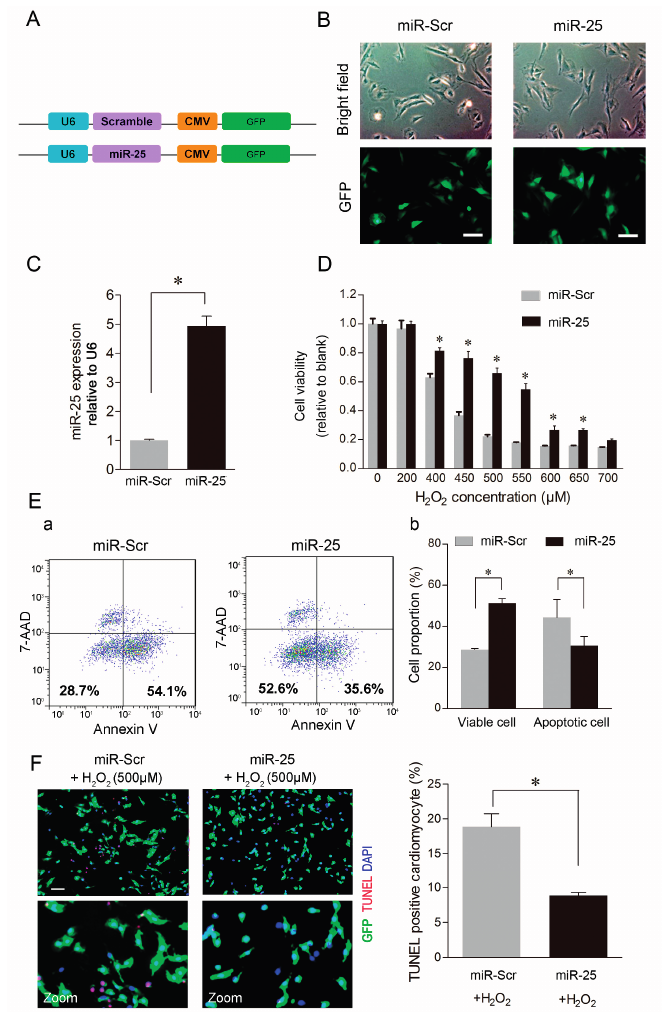
Figure 2. Over-expression of miR-25 markedly reduced cardiomyocyte apoptosis. ( A ) Schematic illustration of the construction of the lentivirus vectors. H9c2 cells infected with lentiviruses containing miR-25 precursor (miR-25) or a scramble control sequence (miR-Scr) were isolated by fluorescence-activated cell sorting (FACS) based on the green fluorescence emitted from cells expressing GFP, the marker carried by the lentivirus vector, and then plated in 24-well plates for expansion; ( B ) The phase contrast and fluorescent images of H9c2 cells infected with lentiviruses containing miR-25 or miR-Scr. Scale bars: 100 μ m; ( C ) Quantitative RT-PCR showed that miR-25 expression was 4.94 ± 0.34-fold higher in the miR-25 group than that in the miR-Scr group. * p < 0.05 vs. miR-Scr; ( D ) H9c2 cells were stimulated with H 2 O 2 and subjected to CCK-8 assay. Serial concentrations of H 2 O 2 were applied to examine the effects of miR-25 overexpression; ( E ) Panel a : representative dot-plot diagrams of FACS analysis on H9c2 cells stained with annexin V and 7-AAD. The lower left quadrants represents the viable cells (Annexin V − /7-AAD − ), and the lower right quadrants represents the apoptotic cells (Annexin V + /7-AAD − ); Panel b : percentages of viable and apoptotic cells; ( F ) Representative images and quantification of the TUNEL assay. Apoptotic cells were stained red by the TUNEL assay. Scale bars: 100 μ m. Data are means ± SD from three independent experiments. * p < 0.05 vs. respective